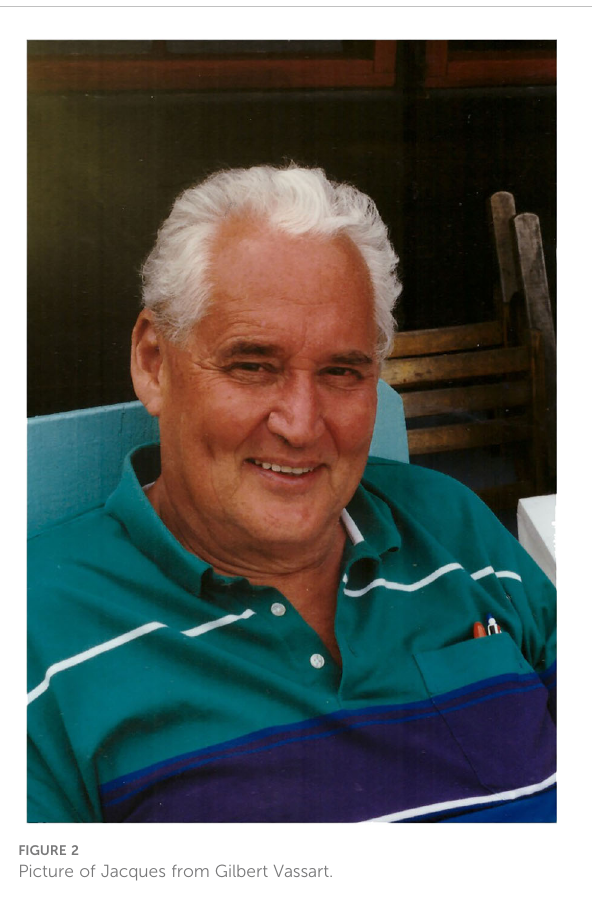
FIGURE 2 Picture of Jacques from Gilbert